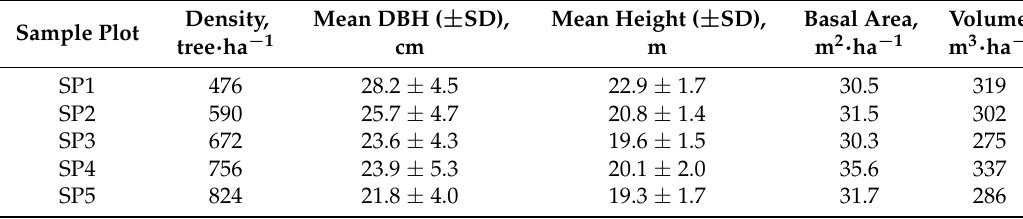
Table 1. Main characteristics of five 82-year-old Scots pine sample stands. Density, Mean DBH ( ± SD), Mean Height ( ± SD), Basal Area, Volume, Sample Plot tree · ha − 1 cm m m 2 · ha − 1 m 3 · ha − 1 SP1 476 28.2 ± 4.5 22.9 ± 1.7 30.5 319 SP2 590 25.7 ± 4.7 20.8 ± 1.4 SP3 286 DBH—diameter at breast height, SD—standard